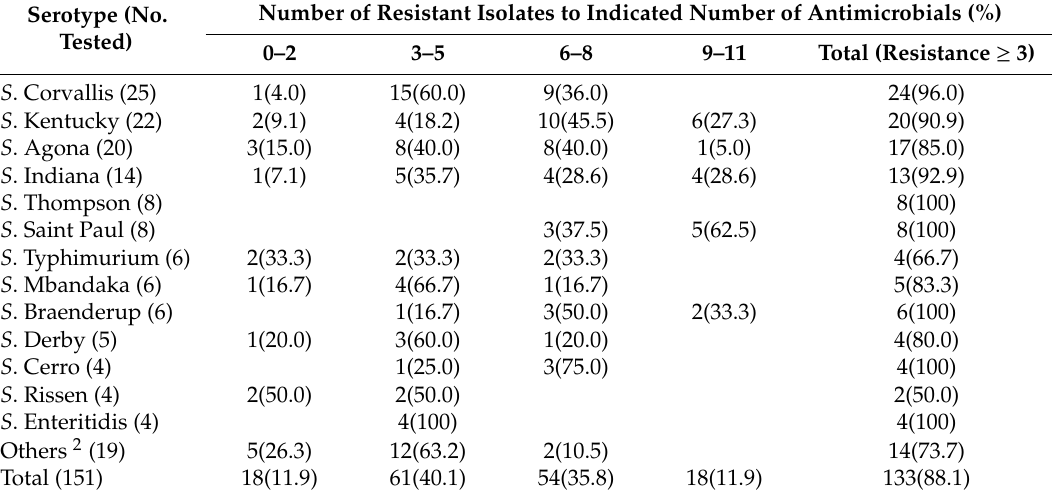
Table 3. Multidrug resistance (MDR) observed among Salmonella serotypes ( n = 151). Serotype (No.